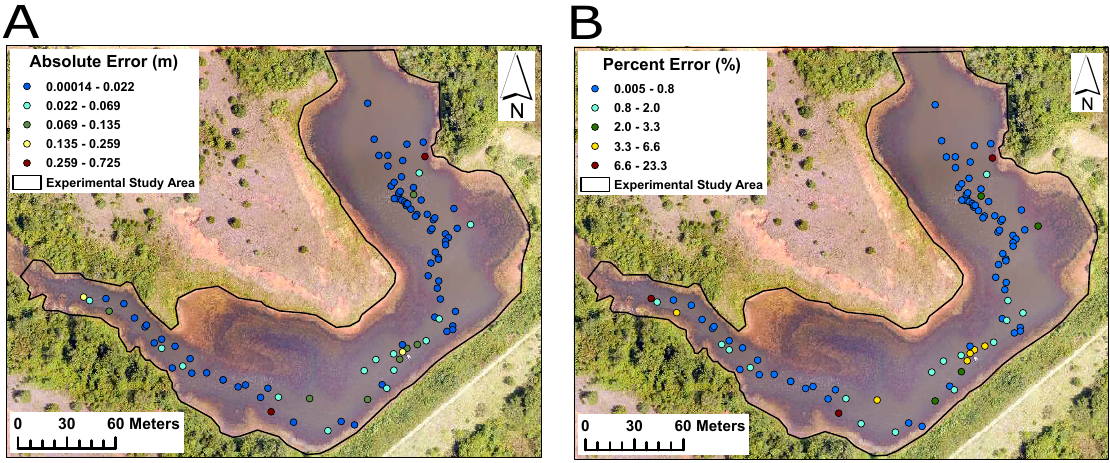
Figure 6. Spatial variability of ( A ) AE (m) and ( B ) PE (%), between the field and echosounder measurements at 100 collocated points within the reservoir